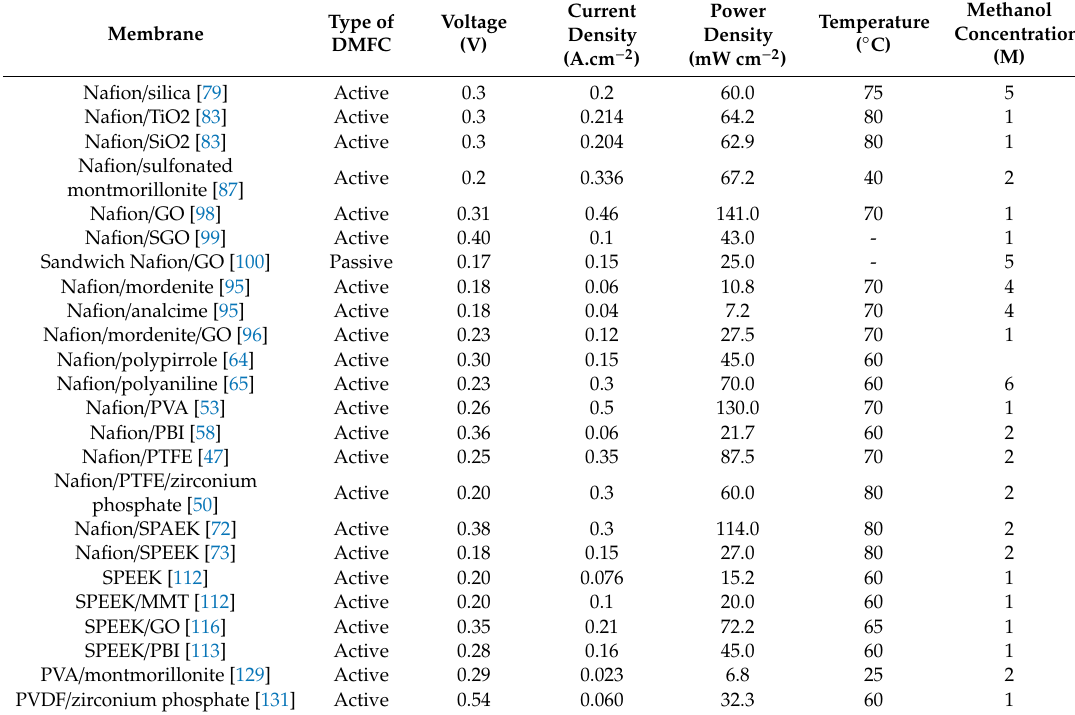
Table 2. Summary of DMFC best performance using composite